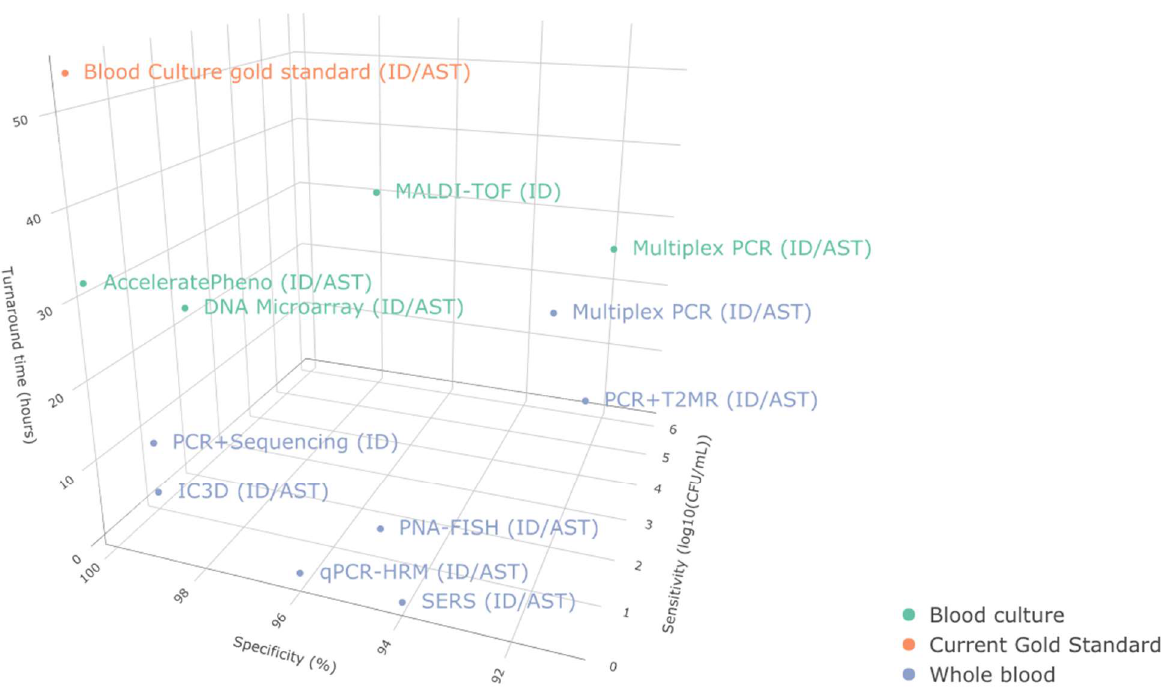
Figure 4. Performance characteristics of current and emerging technologies. Sensitivity, specificity, and turnaround time compared against the current gold standard. 1. qPCR-HRM, 2. SERS, 3. IC3D, 4. PNA-FISH 5. PCR+T2MR, 6. Multiplex PCR from whole blood, 7. PCR + sequencing, 8. Multiplex PCR from blood culture, 9. DNA Microarray, 10. MALDI-TOF, 11. AcceleratePheno, and 12. Blood culture gold standard. Table 3. Comparison of Existing and Emerging BSI Diagnosis Technologies.